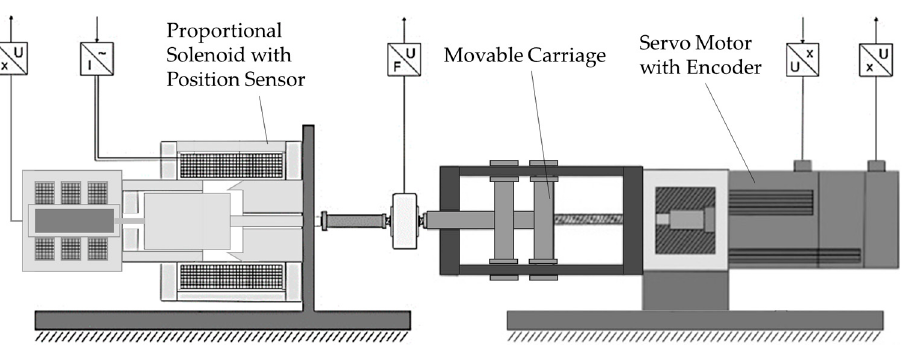
Figure 5. Relationship Between Spool Position, Axial Force and Flow Rate.